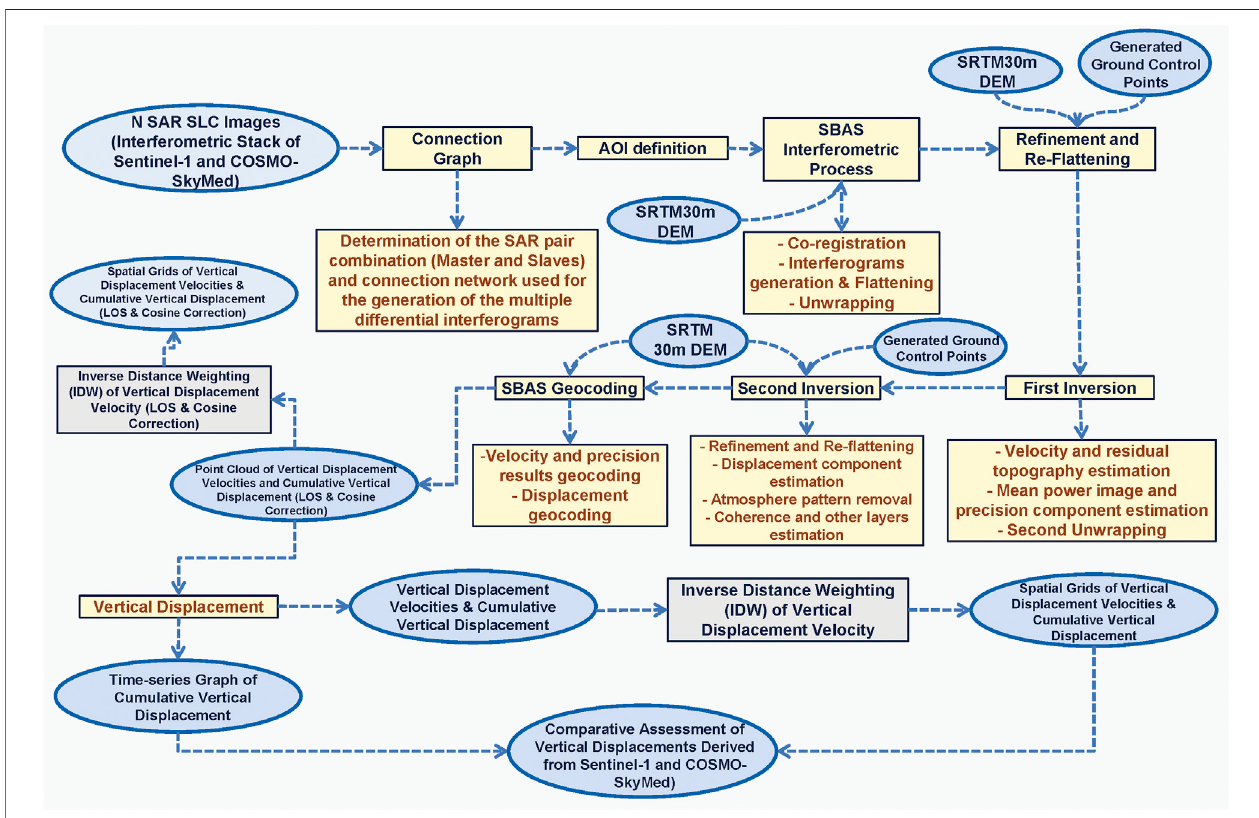
FIGURE4| Work fl